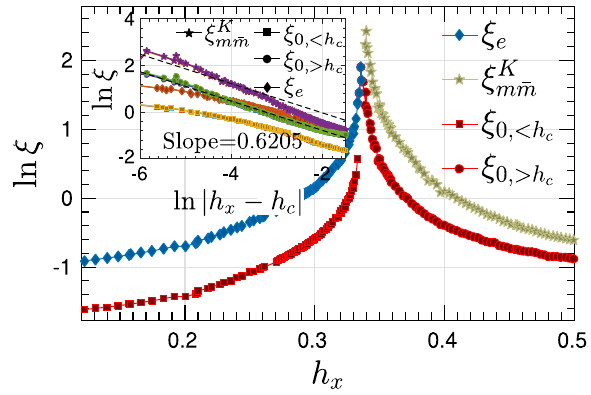
FIG. 8. Scaling of different correlation lengths along line II: Inverse mass gap ξ for charges (in the topological phase), e confinement length ξ K for fluxes (in the trivial phase), and m ¯ m trivial correlation length ξ 0 . The scaling analysis (inset) shows that they all exhibit the same critical exponent, which matches that of the 3D